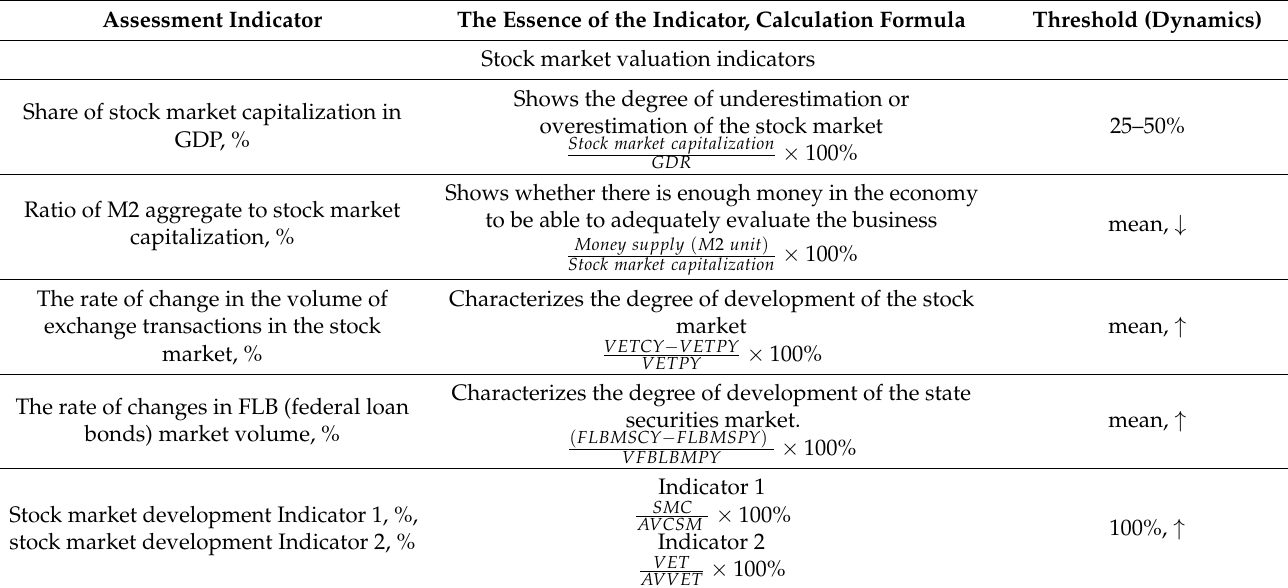
Table 1. Calculation